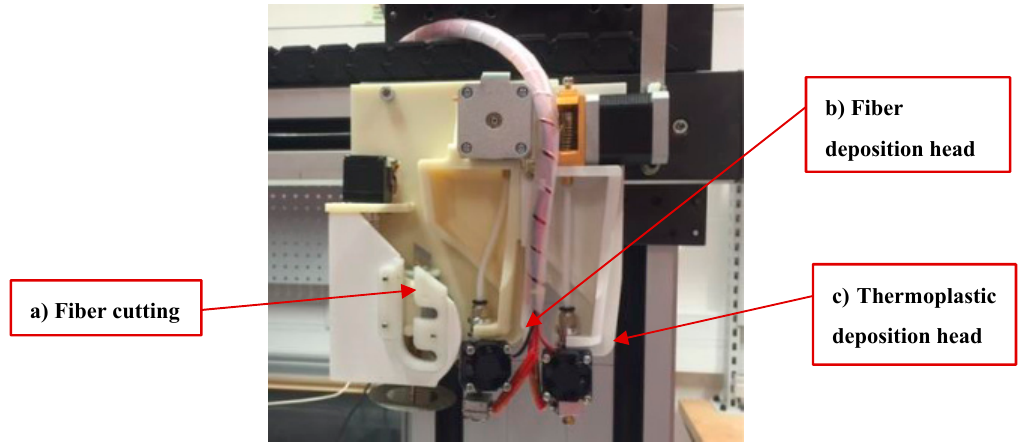
Figure 7. Integrated double extrusion and fiber cutting systems; ( a ) fiber cutting system; ( b ) fiber deposition head; ( c ) thermoplastic filament deposition head.